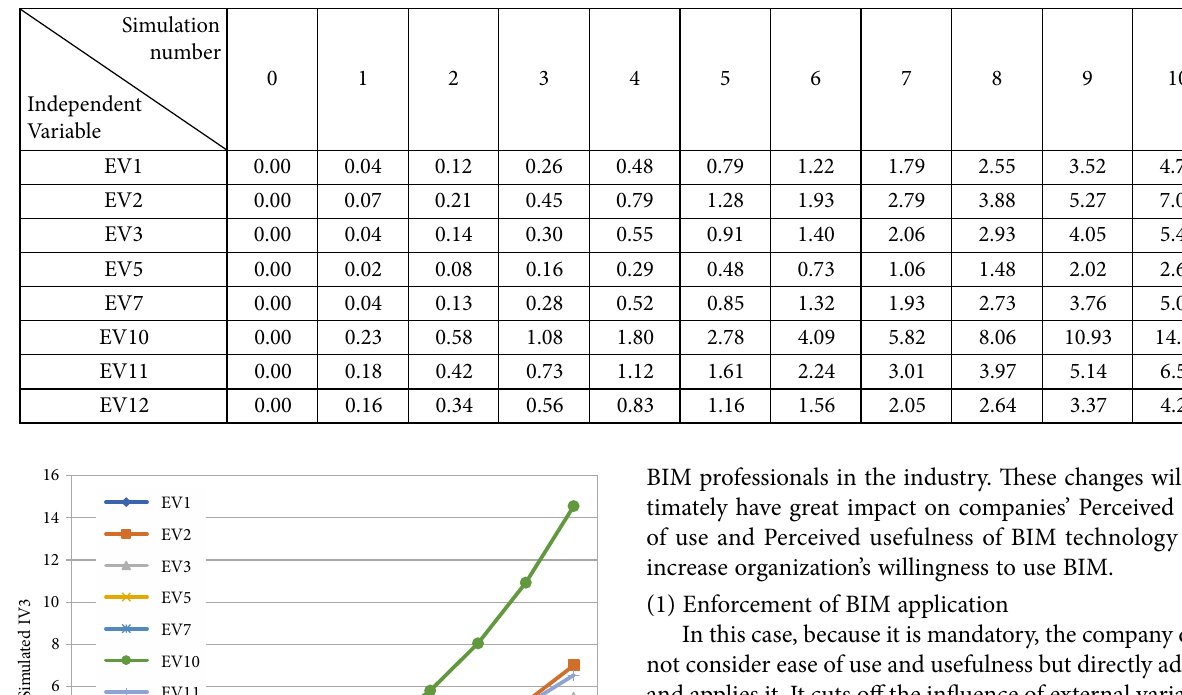
Table 10. Simulation results